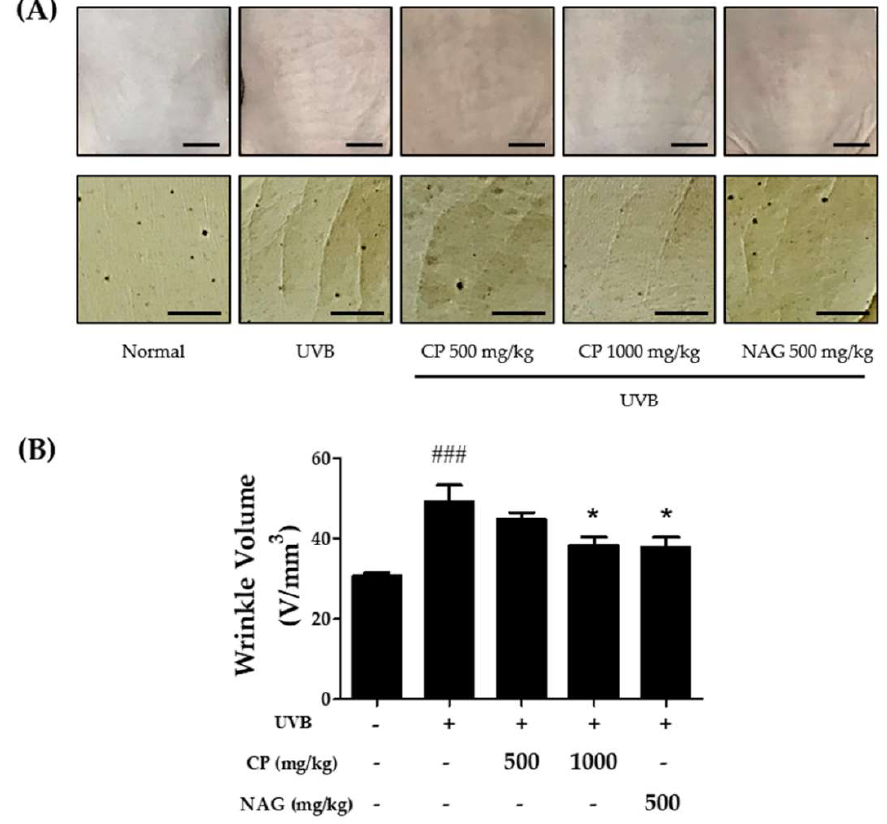
Figure 4. Effect of oral administration of collagen peptide on visible skin condition and wrinkle formation in UVB-induced hairless mice. ( A ) Photographs of a skin surface and replica impression of the mouse dorsal skin. Scale bar = 5 mm; ( B ) histogram of dorsal wrinkle using a video camera and calculated image analysis. The values are shown as mean ± SEM ( n = 8). ### p < 0.001 (vs. control mice). * p < 0.05 (vs. UVB-irradiated mice).